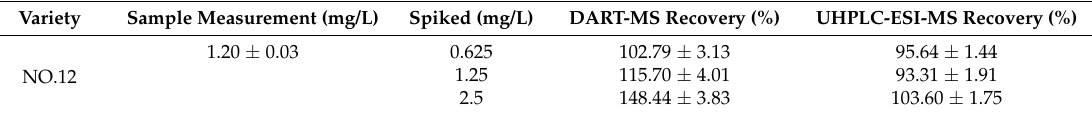
Table 2. The spiked recovery of DART-MS versus UHPLC-ESI-QTOF